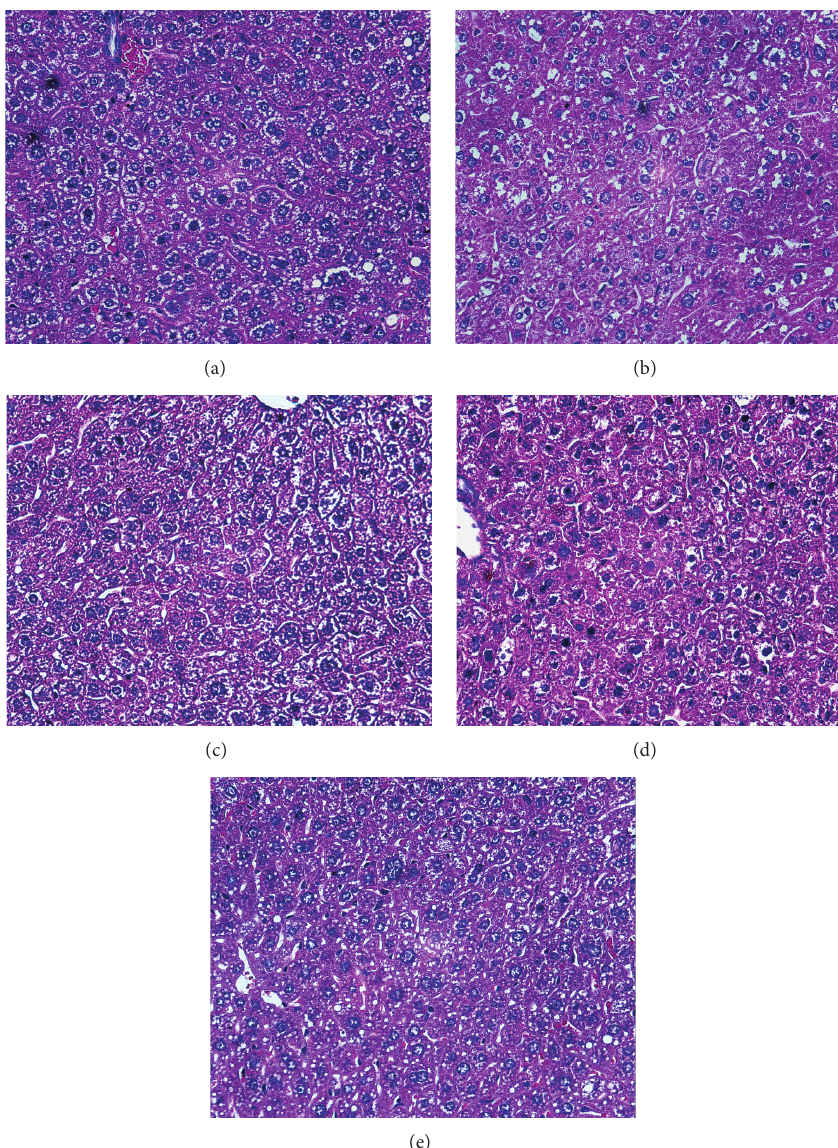
Figure 4: Effects of BBE on pathologic tissue in the livers of STZ-diabetic mice. (a) Normal group; (b) diabetes model control group; (c), (d), and (e) STZ-induced diabetic mice treated with 50, 100, and 200 mg/kg ⋅ BW of BBE,